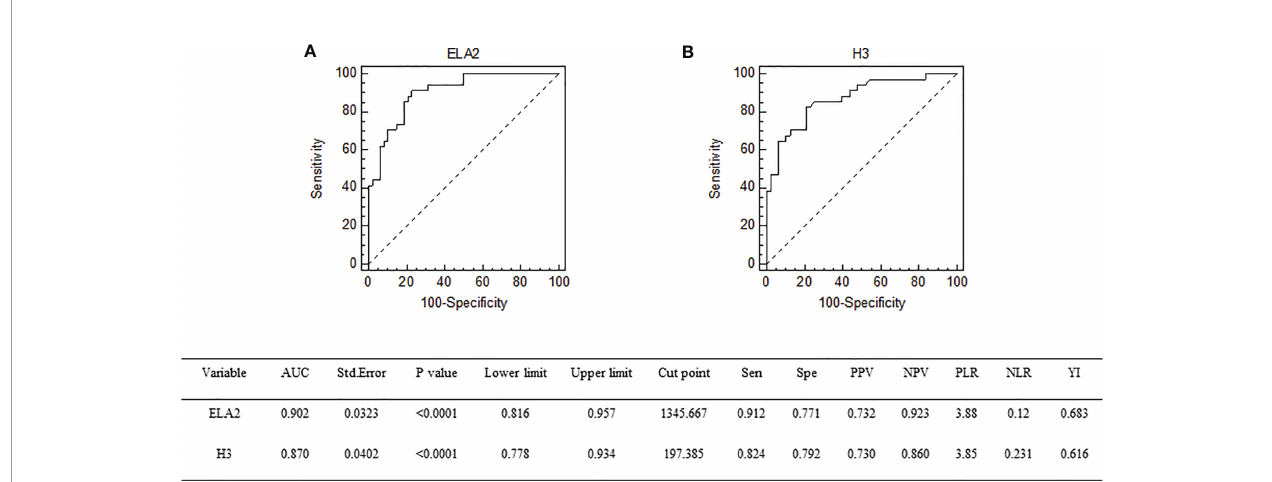
FIGURE 3 | Receiver operating characteristic curve of ELA2 (A) and H3 (B) for prediction of DIC occurrence. DIC, disseminated intravascular coagulation.